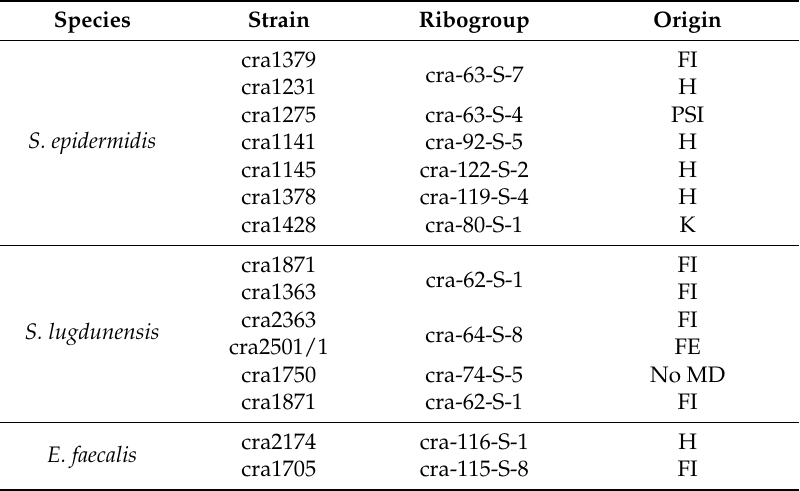
Table 3. Characteristics of S. epidermidis , S. lugdunensis and E. faecalis